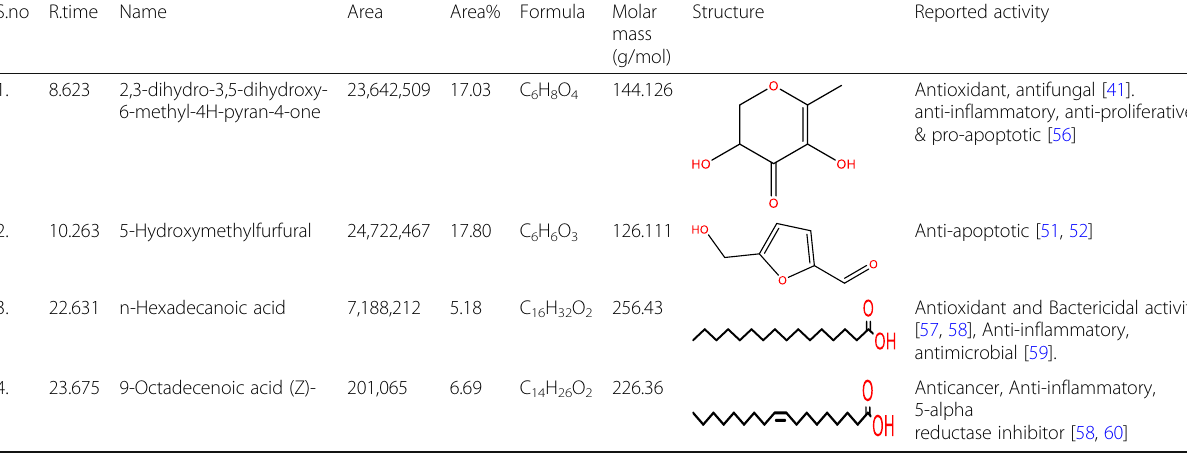
Table 2 Major compounds identified in PTY-2r through GC-MS